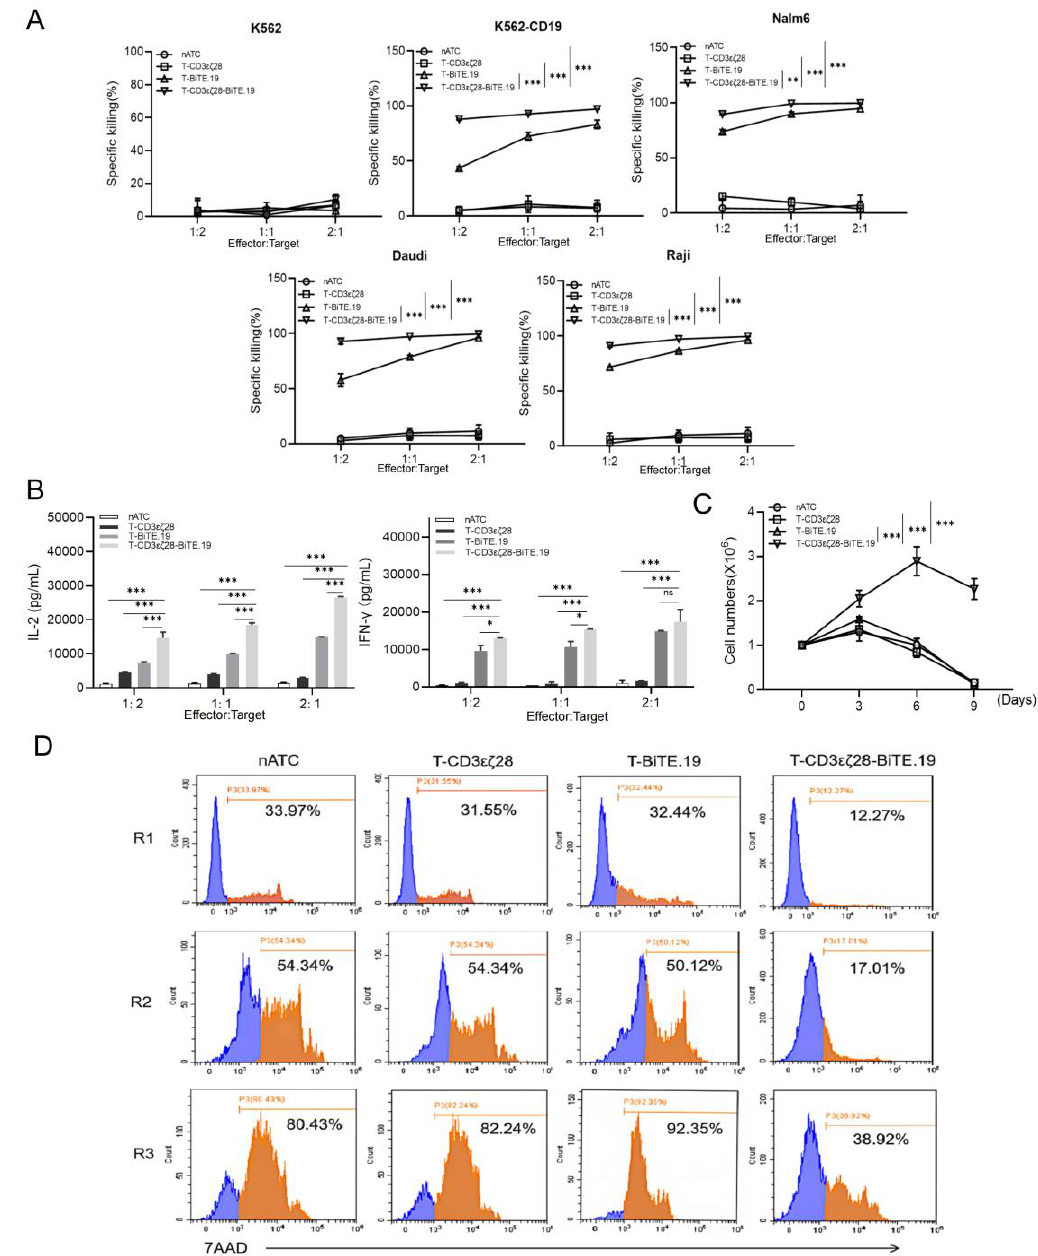
Figure 5. Evaluation of the cancer cell killing effects and persistence of T-CD3 εζ 28-BiTE.19 in vitro. ( A ) Comparison of the cancer cell killing effects of different T cells. Different cancer cells were co-cultured with nATC or T-CD3 εζ 28 or T-BiTE.19 or T-CD3 εζ 28-BiTE.19 at indicated effector to target (E:T) ratios 24 h. The viability of cancer cells was determined by luciferase assays. ( B ) Histograms showed the production of cytokines in different T cells. Nalm6 cells were co-cultured with nATC or T-CD3 εζ 28 or T-BiTE.19 or T-CD3 εζ 28-BiTE.19 at different E:T ratios for 24 h, and then the supernatants were collected. The concentration of IL-2 and IFN- γ in supernatants were detected by enzyme-linked immunosorbent assay (ELISA). ( C , D ) Histograms showed the expansion of T cell during sequential stimulated by cancer cells. The T cells were repeatedly stimulated with Hela-CD19 at an E:T ratio of 5:1 every 3 days. The cell numbers and apoptosis of T cells were counted ( C ) and evaluated by FCM ( D ) on day 3, 6 and 9, respectively. Statistical differences were assessed by mutual comparison between each two groups using multiple comparisons t -test. (* p < 0.05, ** p < 0.01, *** p < 0.001, ns: no